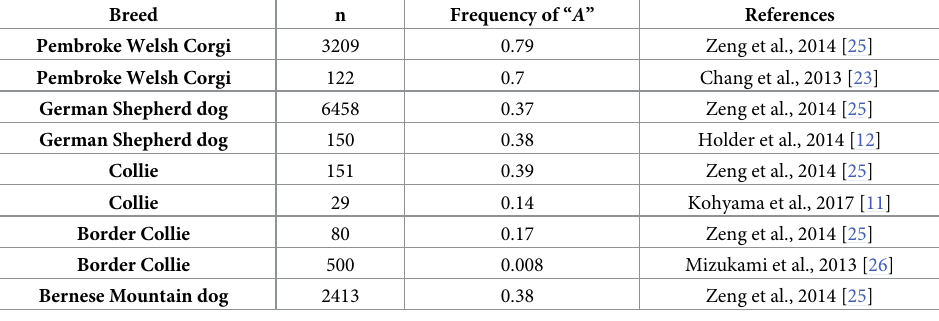
Table 3. Reported frequency of the “ A ” allele in breeds predisposed to canine degenerative myelopathy. Breed